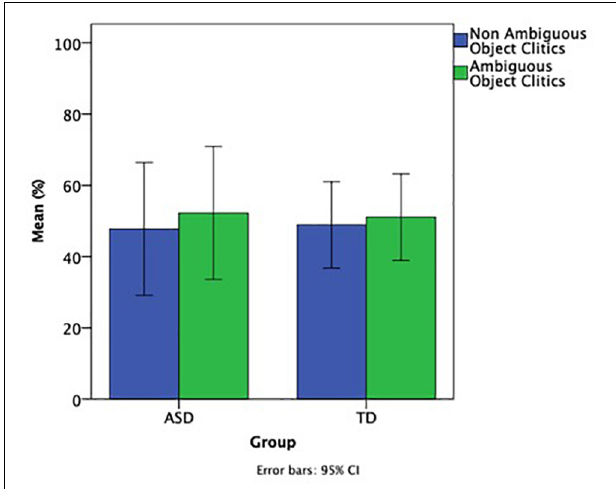
FIGURE 4 | Ratio of ambiguous and non-ambiguous object clitic